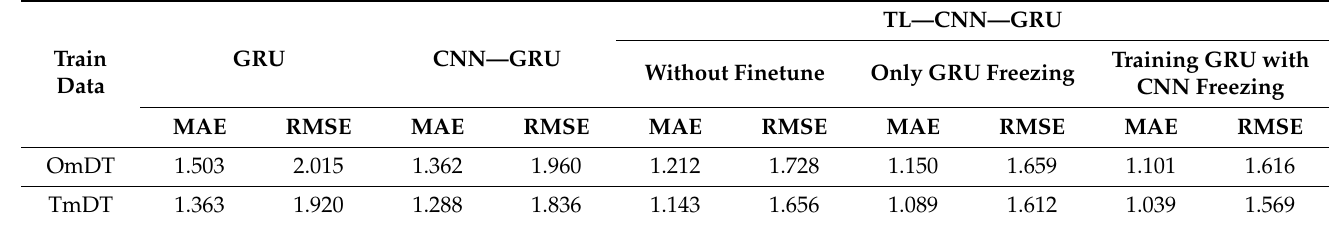
Table 3. Evaluation index accuracy of different model methods.